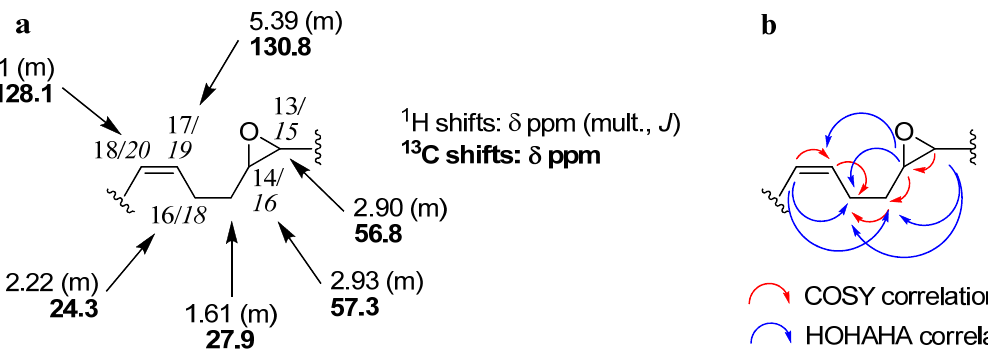
Figure 2. NMR shifts ( a ) and key 1 H- 1 H correlations ( b ) for the epoxy-ene system of 1 + 2